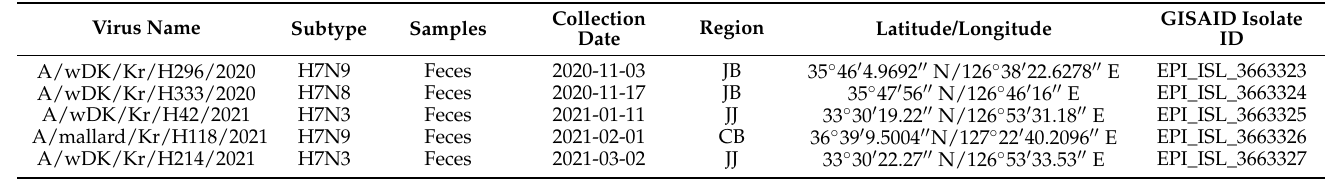
Table 1. H7 isolates used in this study ( n =